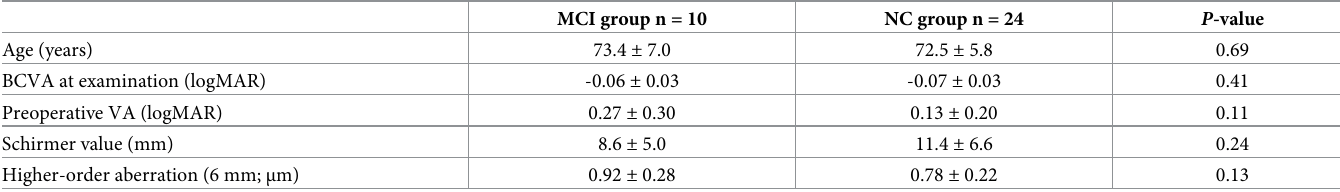
Table 1. Functional VA parameters in the MCI and NC